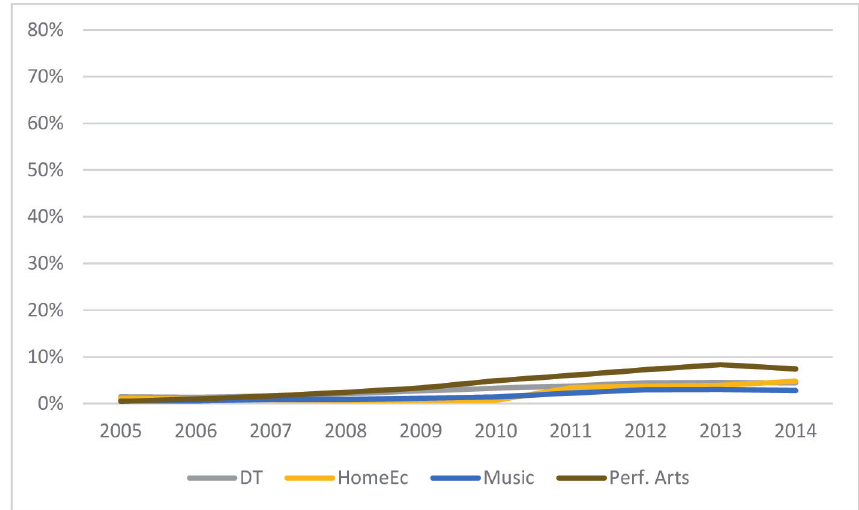
Figure 9: Percentage of pupils entered in non-GCSEs in design and technology, home economics, music, and performing arts 2005 to